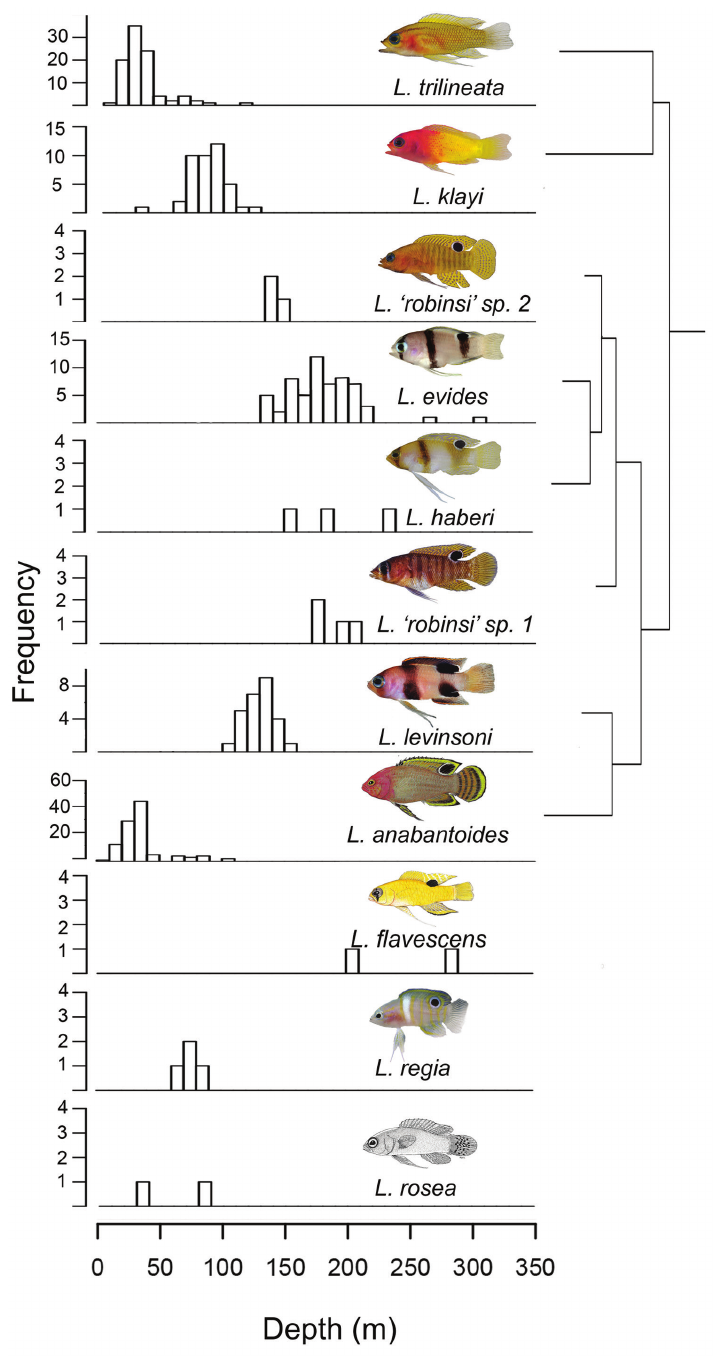
Figure 10. Depth distributions for species of Lipogramma . Photos or illustrations by C. C. Baldwin, D. R. Robertson, R. G. Gilmore, and Mooi and Gill (2002: fig.